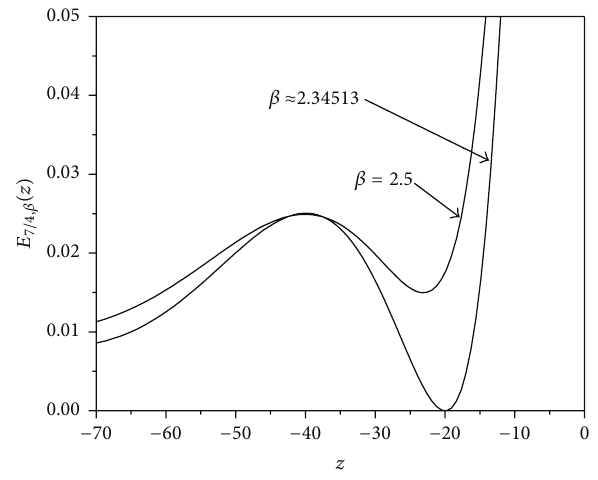
Figure 11: 𝐸 7/4,𝛽 (𝑧) for 𝛽 = 2.34513 and 𝛽 = 2.5 .